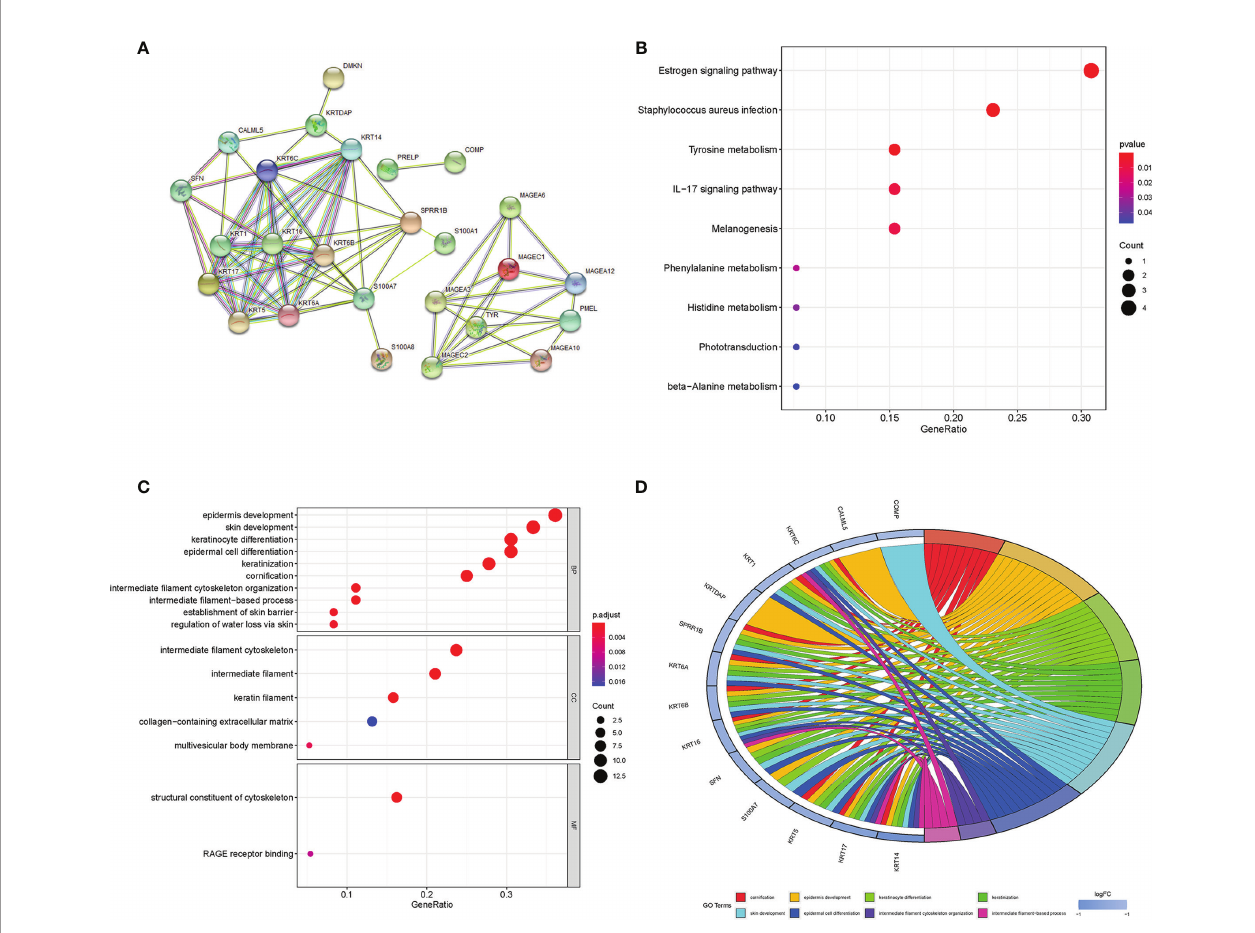
FIGURE 2 | (A) Differential gene protein interaction networks; (B) KEGG enrichment bubble map of differential genes; (C) GO enrichment analysis bubble diagram of differential genes (color represents P value, the redder the color, the more signi fi cant the difference; The length of the histogram and the bubble size of the bubble graph represent the degree of enrichment) (D) GO enrichment circle diagram of the differential